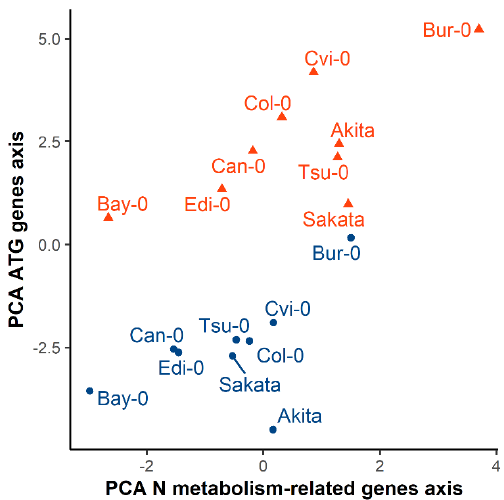
Figure 7. Comparison of global genes expressions among the nine Arabidopsis accessions following the groups of N metabolism related genes and ATG genes. The accessions are distributed in the two conditions following their coordinates onto the PCA N metabolism-related genes axis 1 and the PCA ATG genes axis 1. Blue dots and red triangles show the plants grown respectively in the control and N starvation conditions.